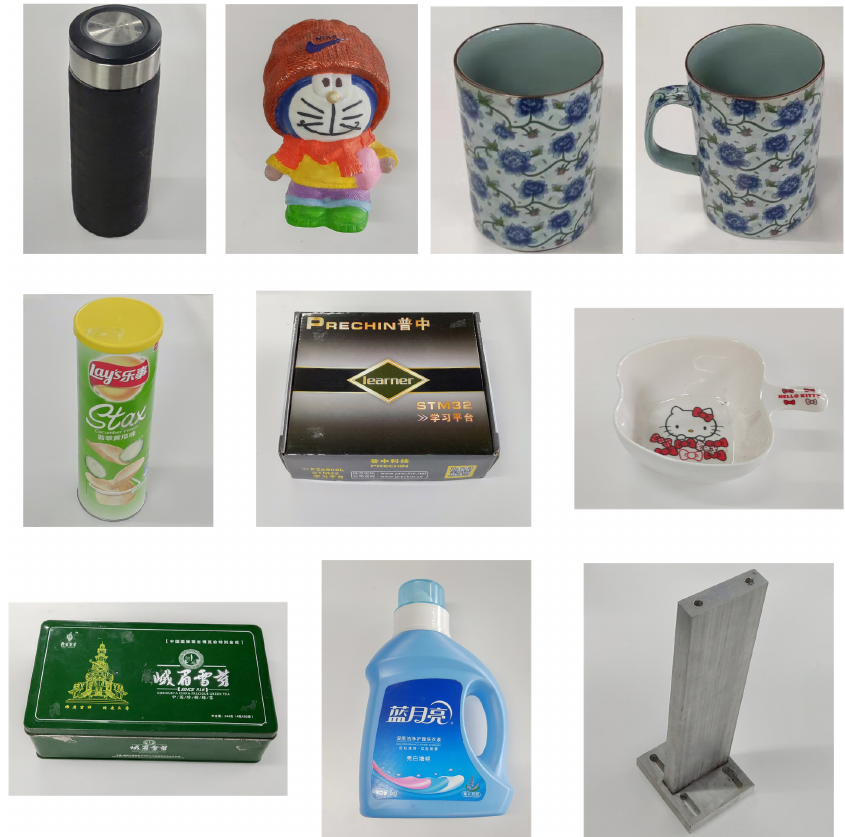
Figure 9. The objects present in the SIAT dataset.